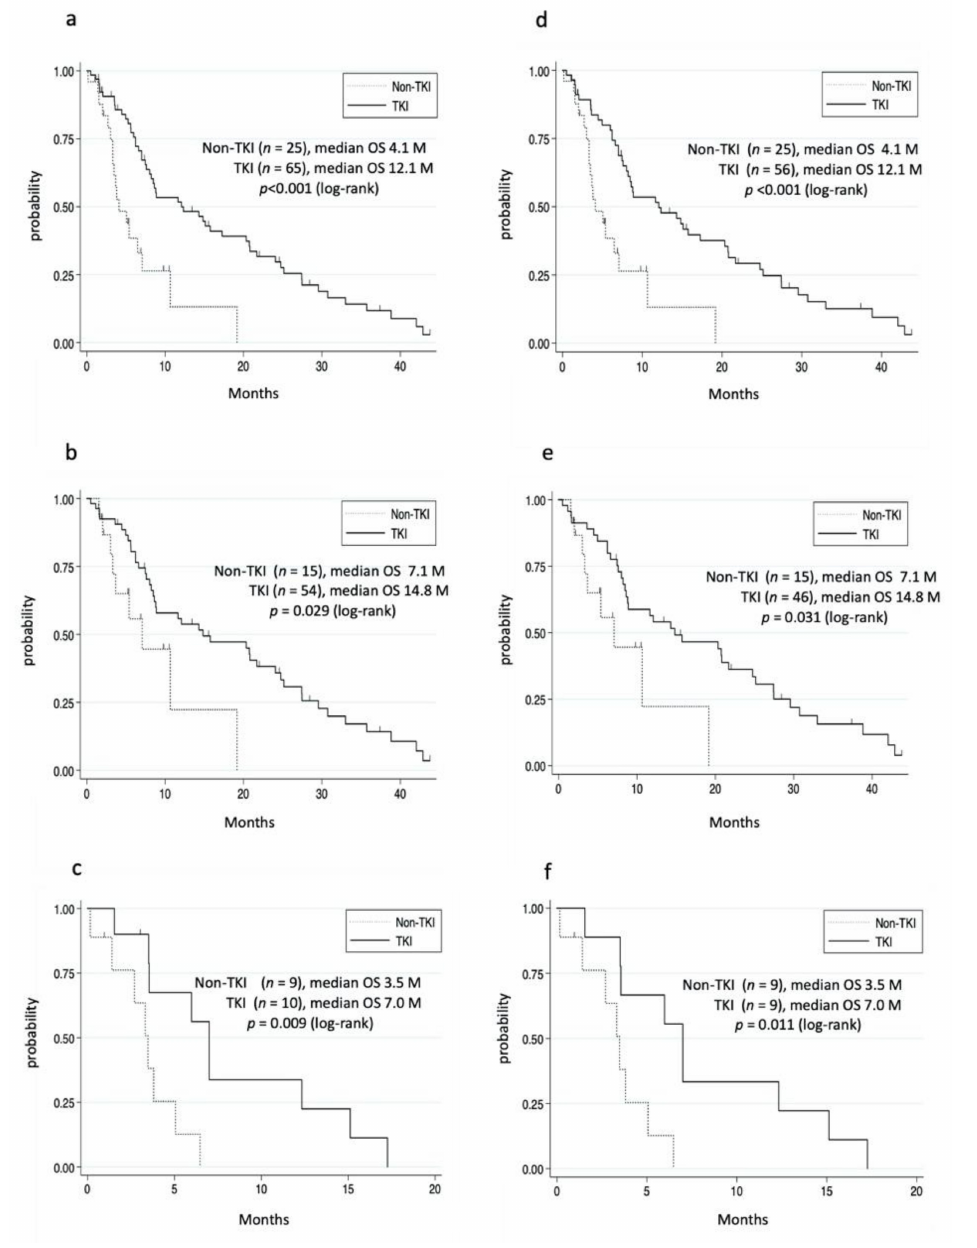
Figure 2. Cumulative survival rate of the non-TKI and TKI groups. ( a – c ) Patients with extrahepatic metastases who used TKI. ( a ) In the TKI group, survival rates at 1 and 3 years were 51.5% and 11.7%, respectively. In the non-TKI group, survival rates at 1 and 3 years were 13.1% and 0%, respectively. ( b ) Child–Pugh class A. In the TKI group, the survival rates at 1 and 3 years were 55.9% and 14.2%, respectively. In the non-TKI group, the survival rates at 1 and 3 years were 22.4% and 0%, respectively. ( c ) Child–Pugh class B. In the TKI group, the survival rates at 1 and 3 years were 33.8% and 0%, respectively. In the non-TKI group, the 1 year survival rate was 0%. ( d – f ) Patients who started TKI after being diagnosed with extrahepatic metastases. ( d ) The survival rate of the TKI group at 1 and 3 years were 51.4% and 12.6%, respectively. ( e ) Child–Pugh class A. The survival rates of the TKI group at 1 and 3 years were 56.5% and 15.7%, respectively. ( f ) Child–Pugh class B. The survival rates of the TKI group at 1 and 3 years were 33.3% and 0%,